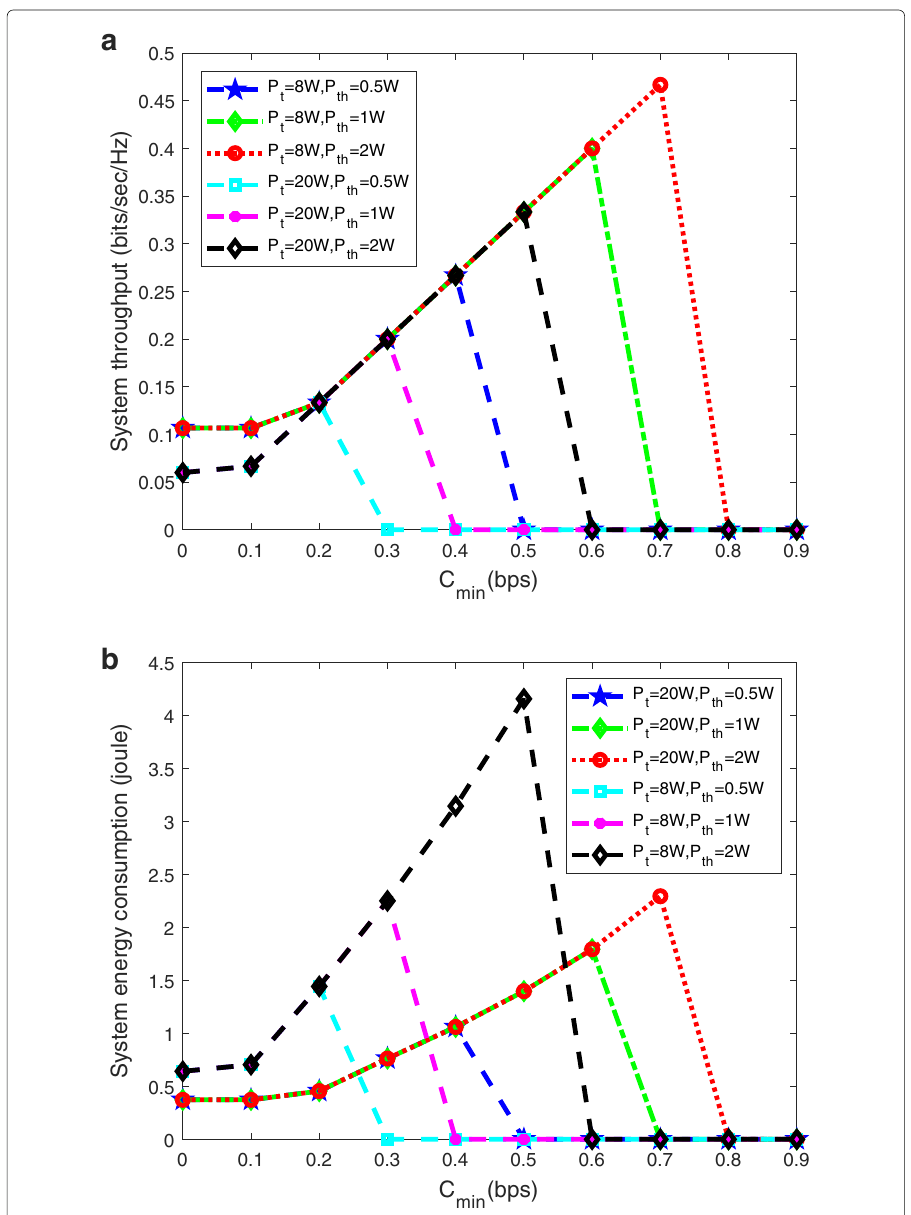
Fig. 5 Expected system performance of throughput/energy consumption versus C min . a System throughput analysis versus C min . b System energy consumption analysis versus C min